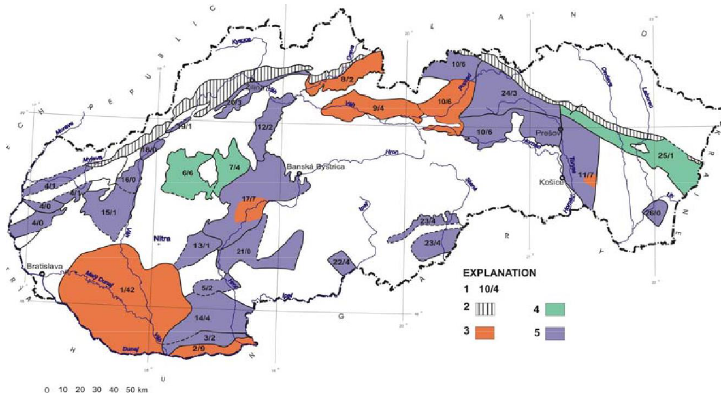
Figure 1. Prospective areas of geothermal waters in Slovakia [19]. 1) 10/4; 2) Klippen belt; 3) prospective areas where hydrogeothermal evaluation has been carried out; 4) prospective areas